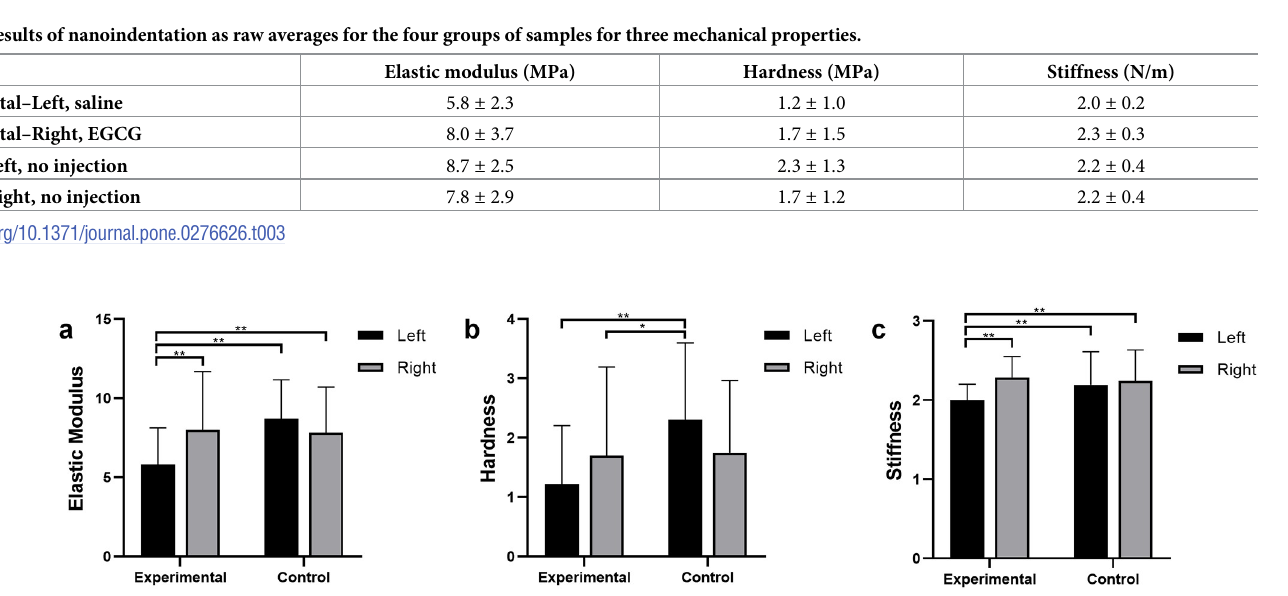
Fig 6. Bar charts indicating the raw averages and standard deviations for the four groups shown in Table 3. ( � p < 0.05, �� p < 0.01). https://doi.org/10.1371/journal.pone.0276626.g006 Table 4. Results of the nanoindentation as normalized values for the two